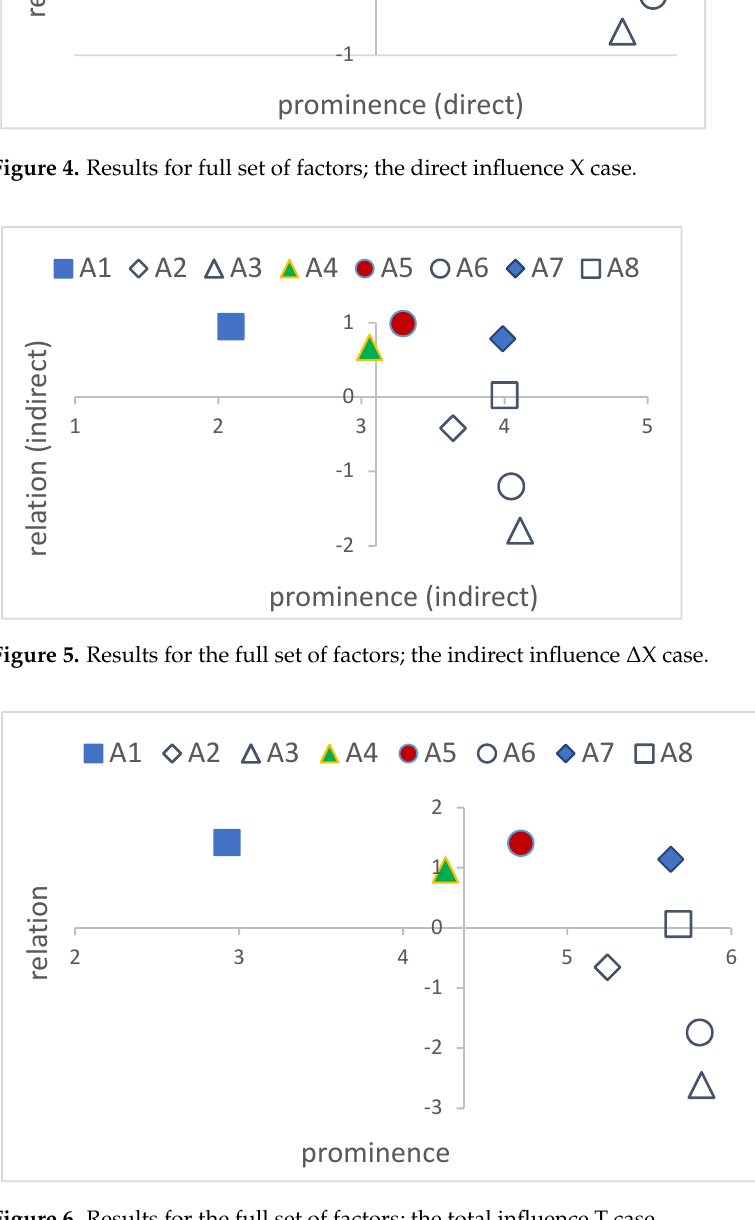
Figure 6. Results for the full set of factors; the total influence T case.